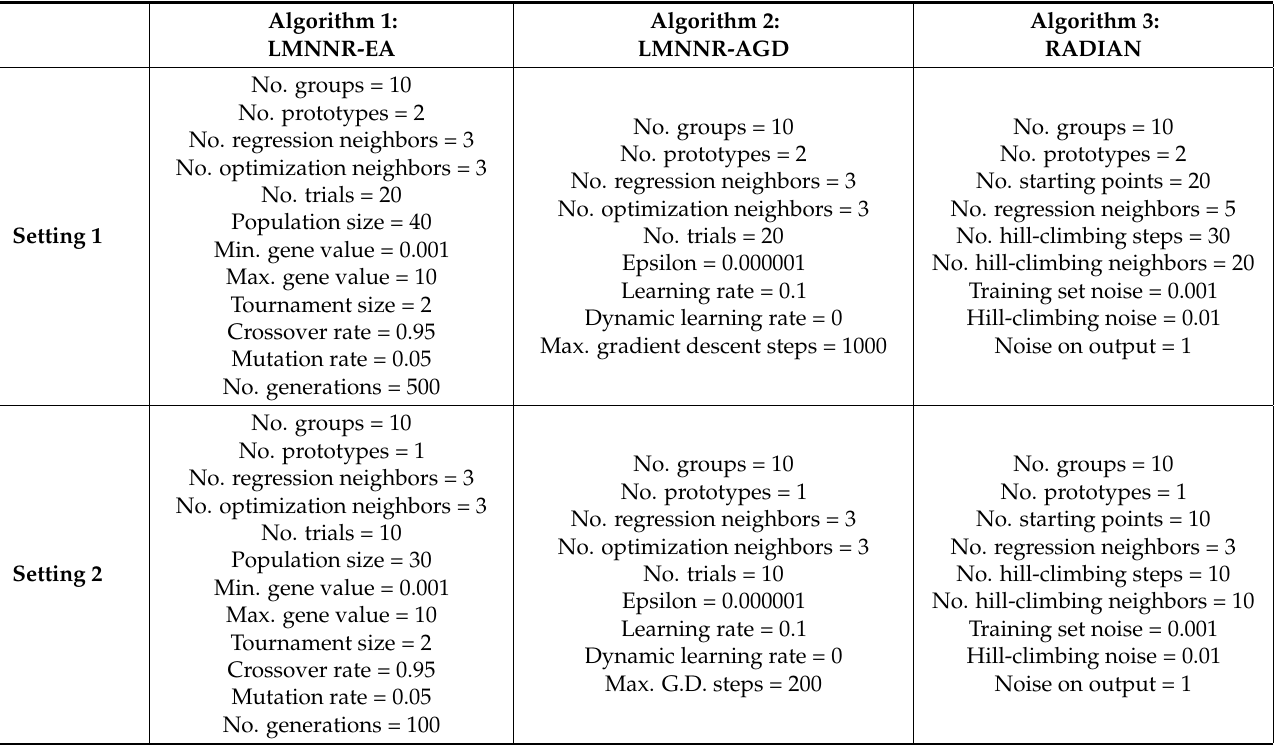
Table 2. The settings of the three regression algorithms. LMNNR-EA: Large Margin Nearest Neighbor Regression Trained with an Evolutionary Algorithm; LMNNR-AGD: Large Margin Nearest Neighbor Regression Trained with Approximate Gradient Descent; RADIAN: Nearest Neighbor Regression with Adaptive Distance Metrics Trained by Multiple Point Hill Climbing on Noisy Training Set